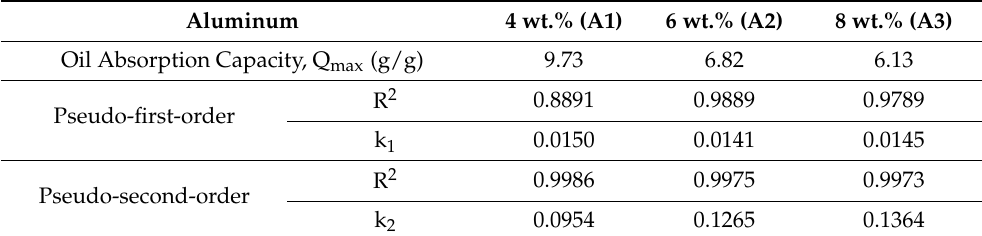
Figure 3. SEM images of AAs with varying Al content (4, 6, 8 wt.%) at 1.5 wt.% CMC and 1.5 wt.% PAA ( a – c , respectively) and varying CMC/PAA concentration (1.0/1.0, 2.0/2.0 wt.%) at 6 wt.% Al ( d , e , respectively). Table 1. Summary of oil absorption capacity for AAs with varying content of aluminum using the pseudo-first- and pseudo-second-order